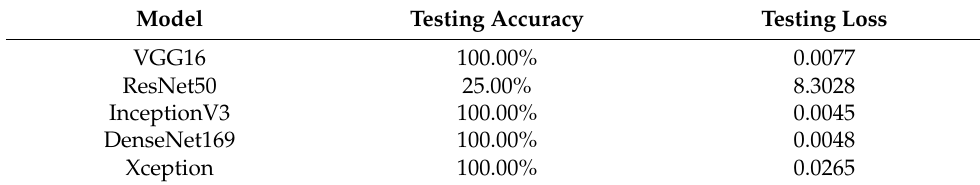
Table 4. Testing accuracies and testing loss when tile size of 500 × 500 pixels was used.